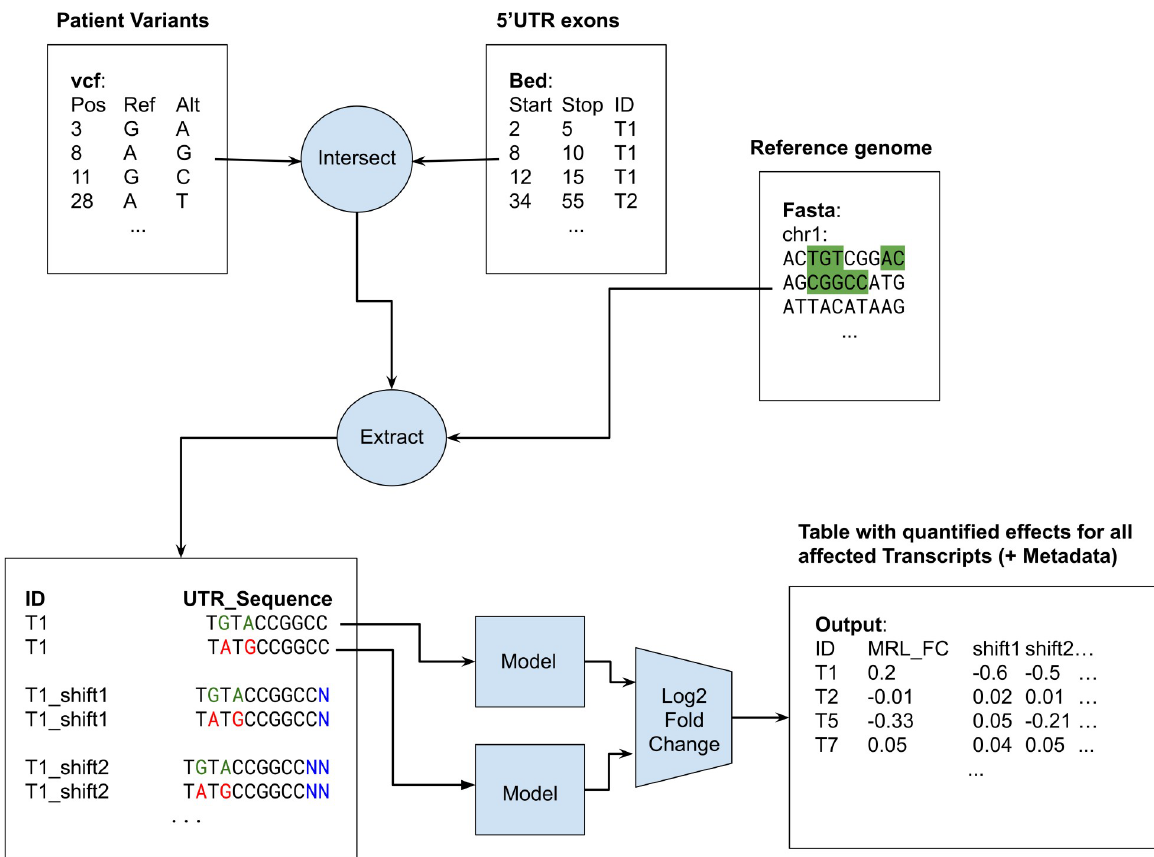
Fig 6. Schematic of the Kipoi model workflow. Using a vcf, bed and fasta file as input, the kipoi model predicts log 2 fold-change in MRL due to variants affecting particular transcript 5’UTRs. Additionally, the model reports the log 2 fold-change in MRL for the same sequences after simulated